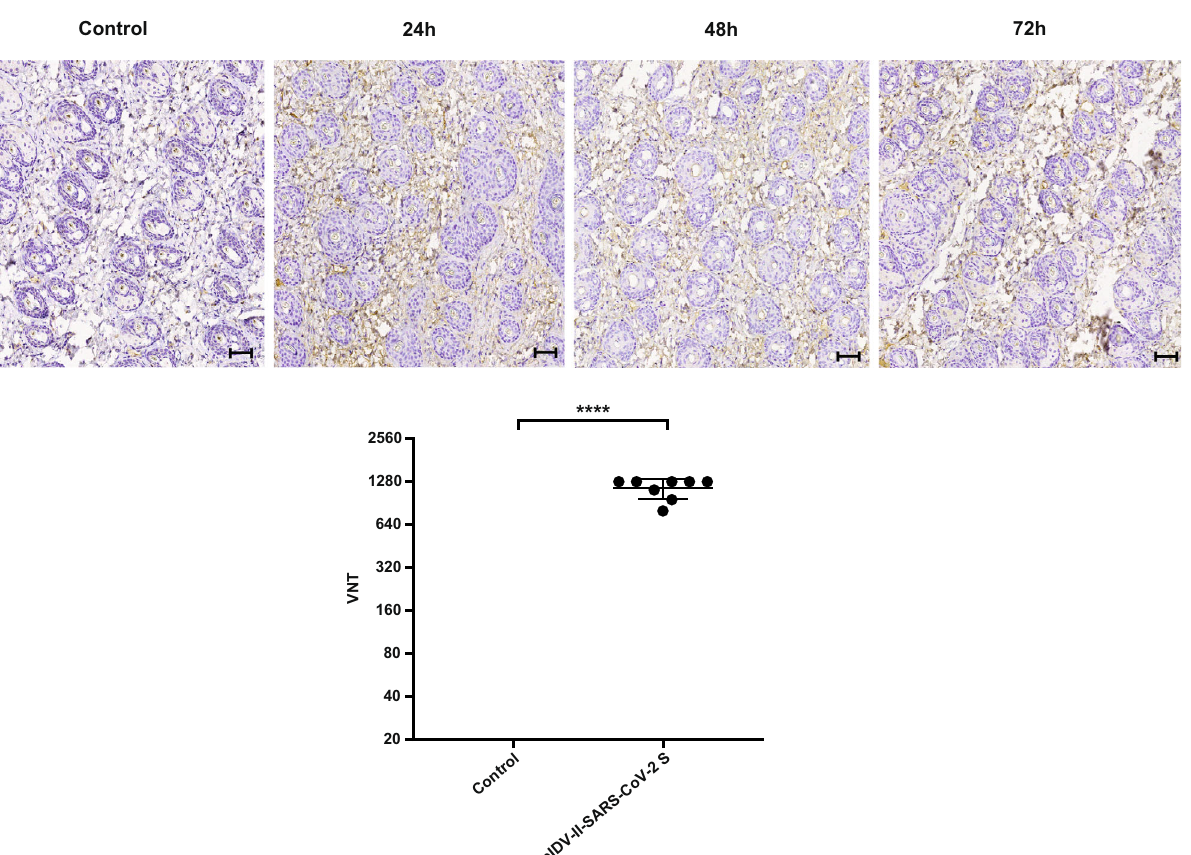
Fig. 7 SARS-CoV-2 DNA vaccine delivery by IONAID induces high expression of spike protein and neutralizing antibody responses. a Representative immunostaining of the SARS-CoV-2 spike protein in mouse dermis tissues (×10 magni fi cation, scale bar = 100 µm). Skin specimens from mice vaccinated with TE buffer (Control group) or 100 µg of pIDV-II-SARS-CoV-2 Spike ( n = 3) were analyzed at 24, 48, and 72 h after vaccination. Positive SARS-CoV-2 Spike protein staining is indicated by brown areas. b Virus-neutralizing titers (VNT) from hamsters vaccinated with TE buffer (control) or pIDV-II-SARS-CoV-2 Spike were analyzed against SB3 (B1) isolate 4 weeks after booster vaccination. Statistical analysis was made using one-way ANOVA, followed by Tukey multiple comparisons test. Asterisks denote statistically signi fi cant data ( ****P <